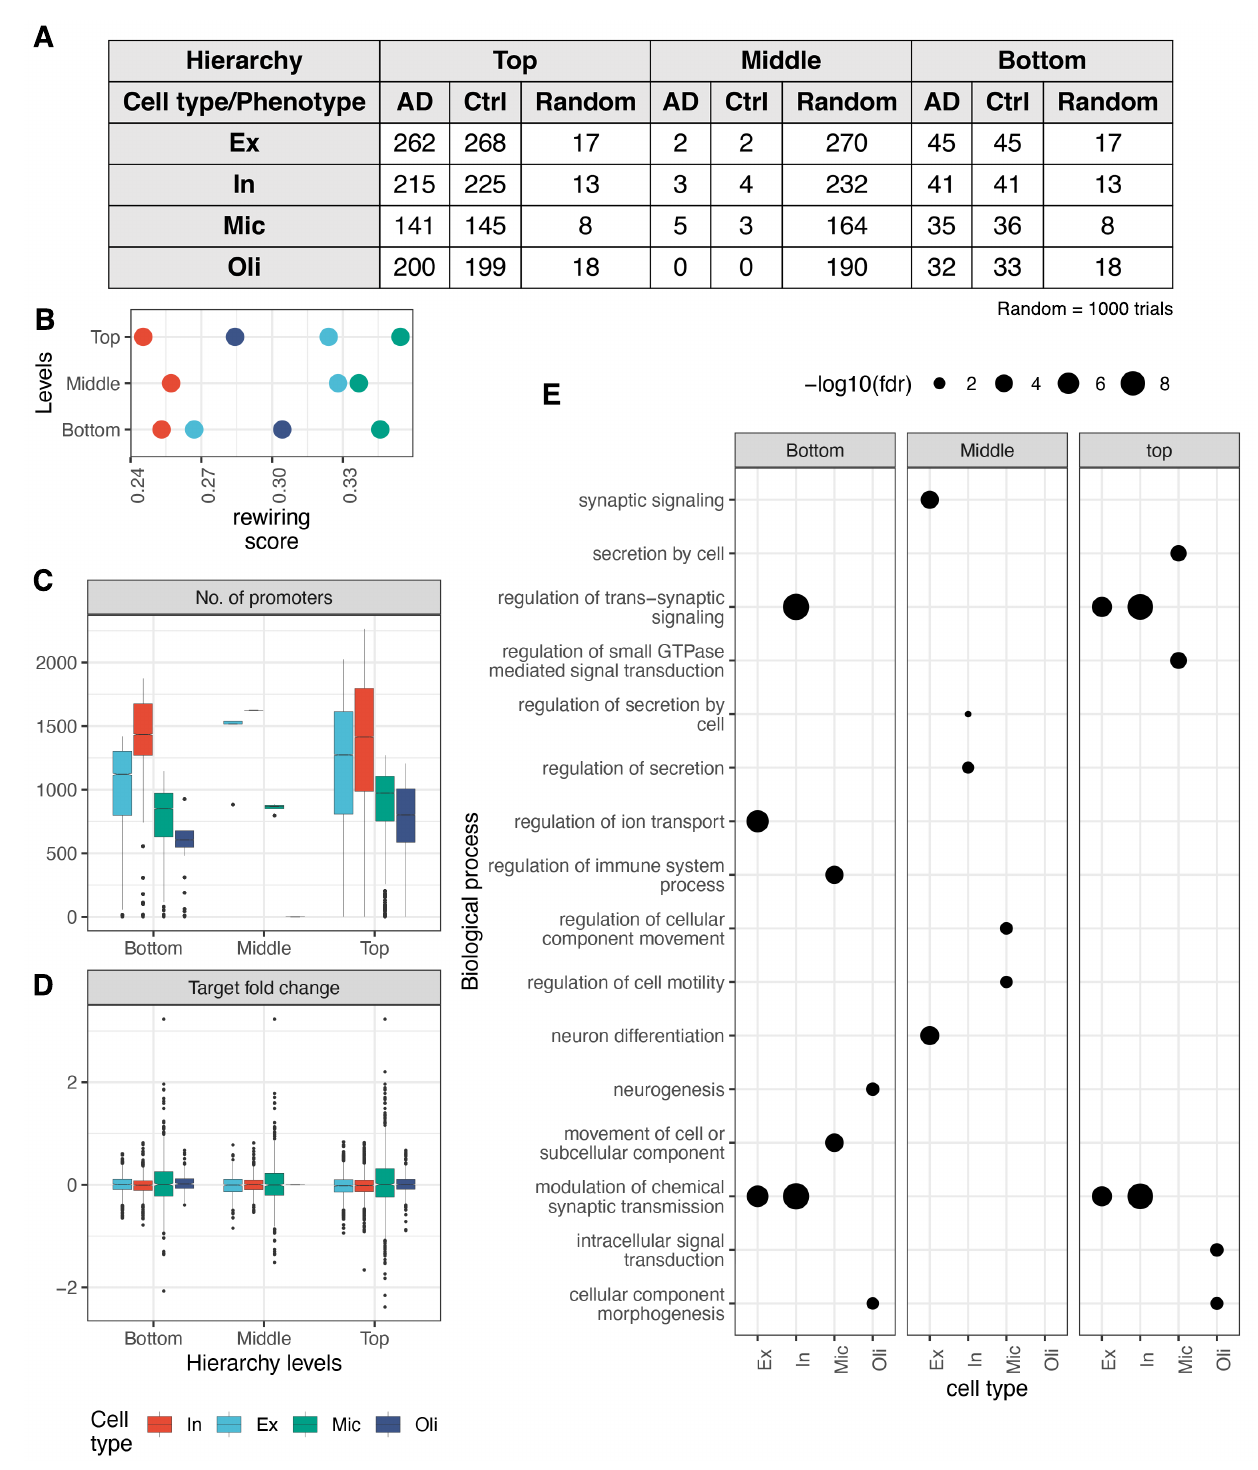
Fig 3. Hierarchy analysis of cell type gene regulatory networks in AD. ( A ) The distribution of TFs in three levels of hierarchy in AD, control and 1000 random GRNs across all four cell types. ( B ) The rewiring scores of TFs (x-axis) across all three levels of hierarchies (y-axis). The distributions of ( C ) number of promoters targeted by TFs (y-axis) and ( D ) the fold change values (log scale; y-axis) of target genes (AD versus healthy controls) of TFs at the three levels of hierarchy (x-axes). ( E ) Enrichment of gene ontology biological processes (y-axis) within targets of top, middle and bottom layers of the regulatory hierarchy across cell type networks